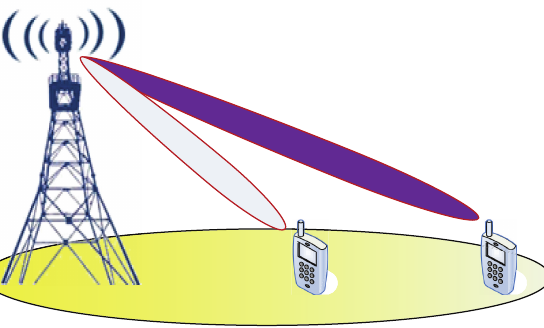
Figure 6: 3D dynamic beamforming in vertical